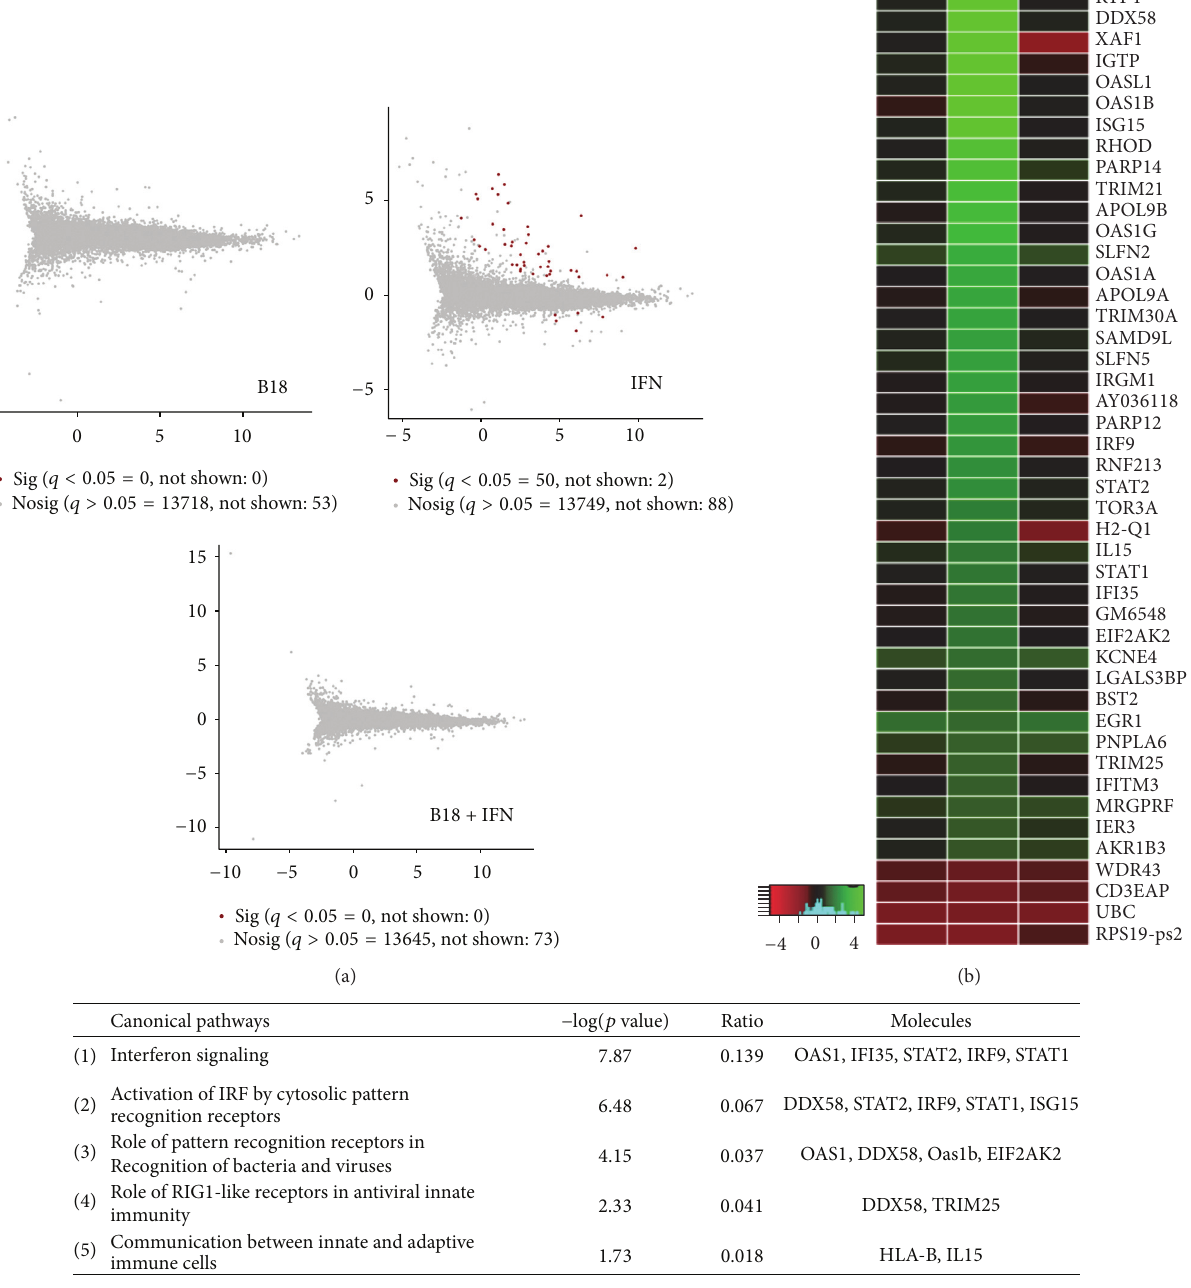
Figure 1: Effect of B18 on type I IFN response. L929 cells were incubated with recombinant B18 protein (B18), with mouse IFN 𝛼 (IFN), or with recombinant B18 and then mouse IFN 𝛼 (B18 + IFN), and analyzed by RNA-seq. (a) Corresponding 𝑀/𝐴 plots representing expression of all cellular genes. 𝑀 value (log 2 fold change) from each transcript between untreated and indicated sample cells is plotted against 𝐴 (overall average log expression level) of each untreated and indicated pair. Red dots indicate SDEGs when compared to untreated cells after differential expression analysis. (b) Heatmap of SDEGs identified after IFN treatment. The heatmap displays the fold change expression (log2) in the indicated samples relative to results for untreated cells. The colour scale is shown at the bottom of the heatmap. (c) Enriched canonical pathways after IPA analysis with SDEGs identified after IFN